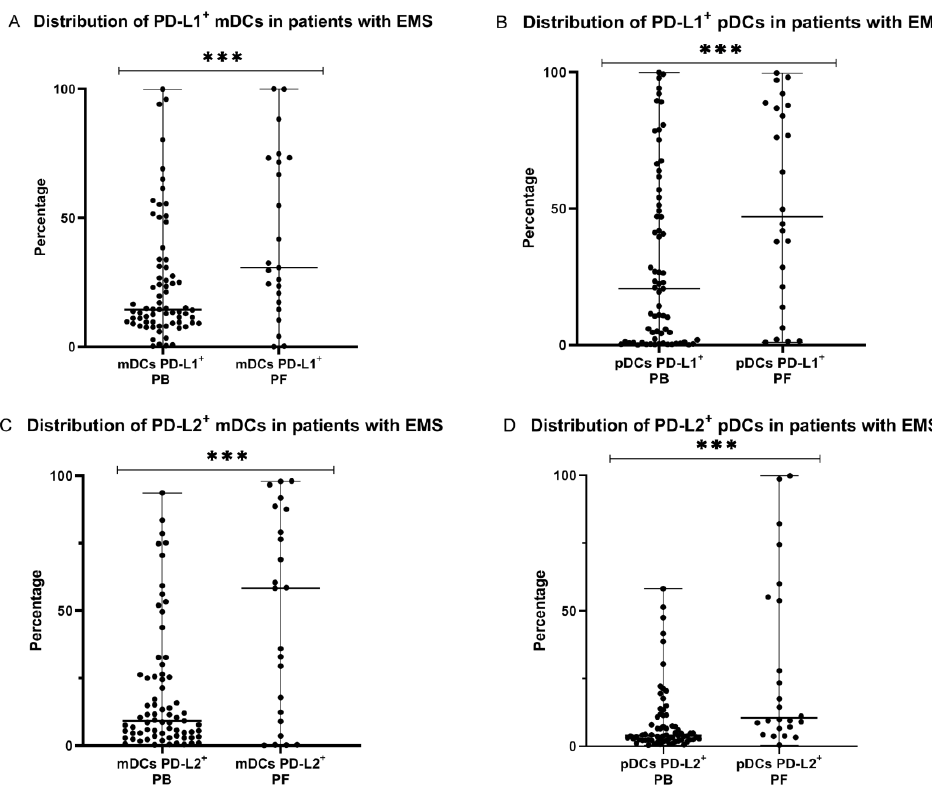
Figure 3. Percentage of mDCs and pDCs with PD-L1 and PD-L2 expression in peripheral blood and peritoneal fluid ( A – D ) in patients with endometriosis. The median values with the following sign indicate statistically significant difference: *** p < 0.001.